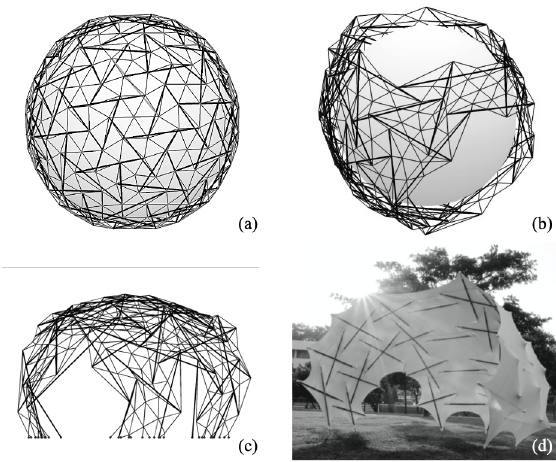
Figure 11: (a, b) Tensegrity balloons; (c) A section of the system in (b) constrained to ground; (d) Knitted tensegrity-membrane system presented at the Expo of the IASS 2019 Symposium in Barcelona [13]. Notice that in the top pictures a sphere is drawn inside the balloon for ease of